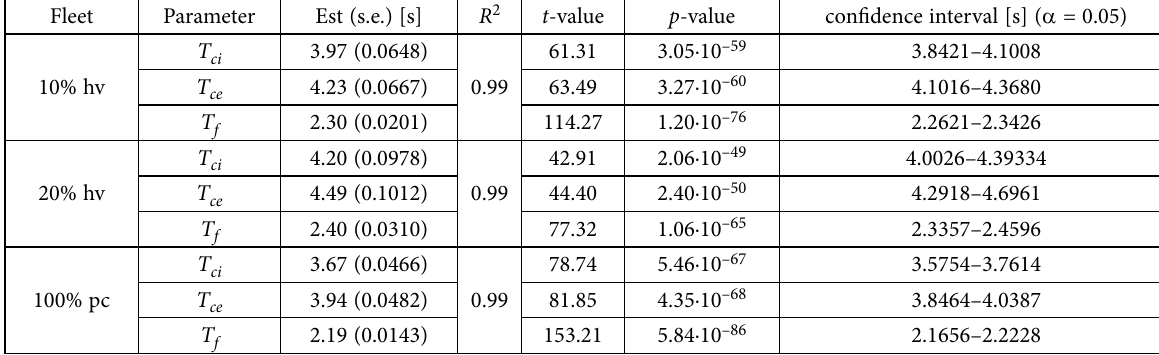
Table 4. Results of regressions for the left-lane on minor